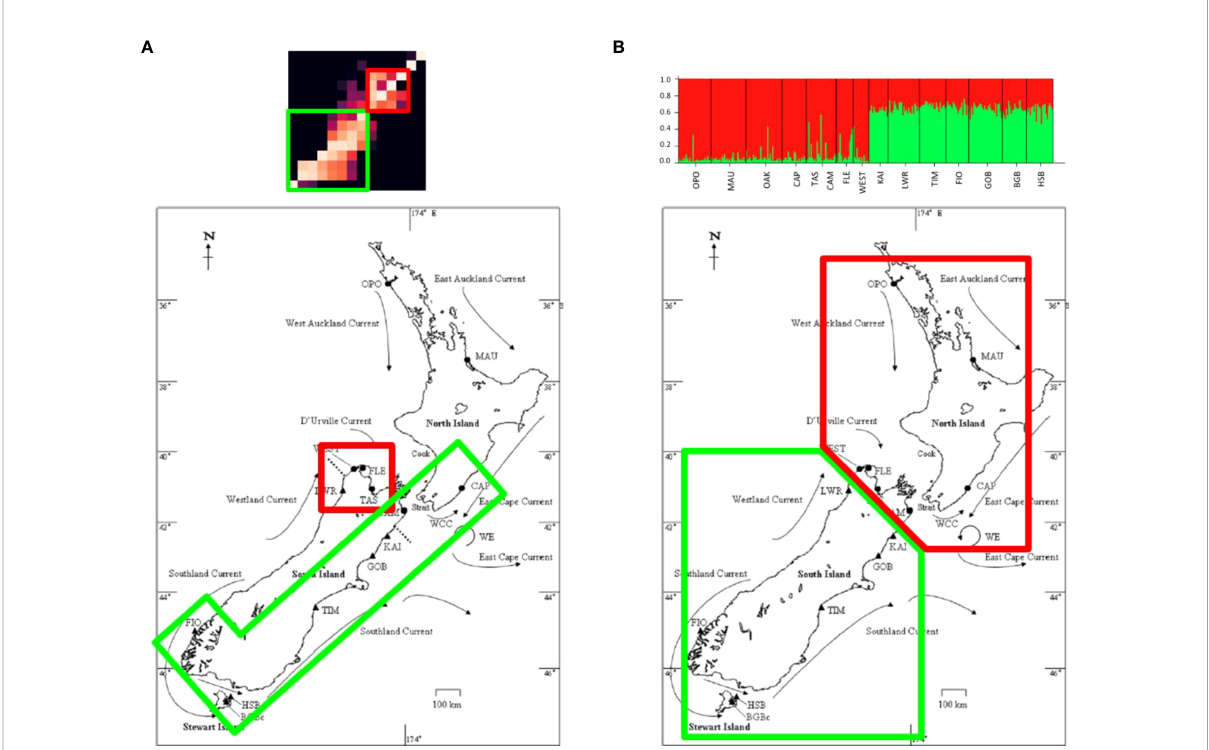
FIGURE 5 Clustering as predicted by (A) the particle tracking model and (B) molecular analyses (in this case, Structure)